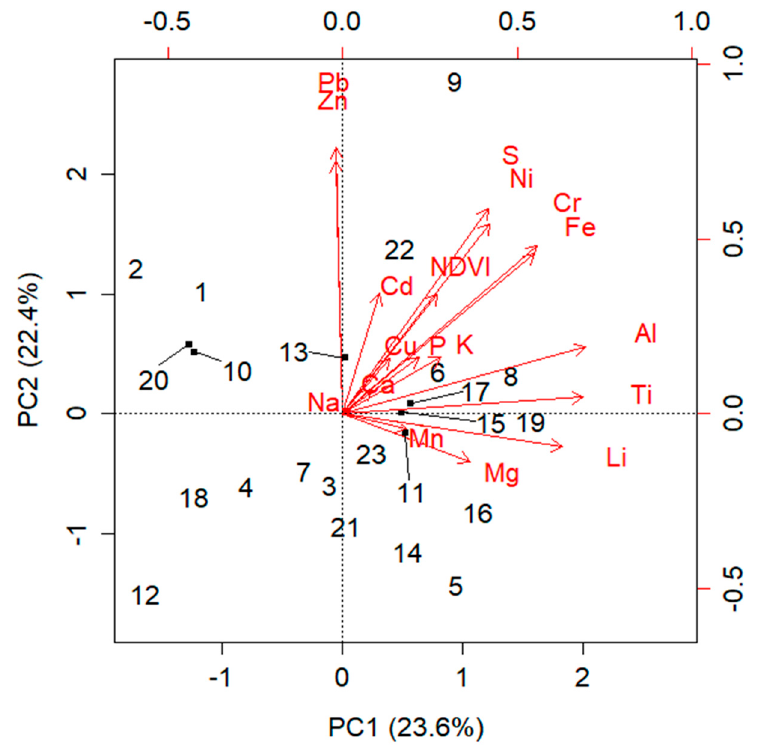
Figure 5. Biplot PC 1 vs. PC 2 , arrows indicate variables and numbers indicate observations. The numbers 1–23 represent the sampling points.